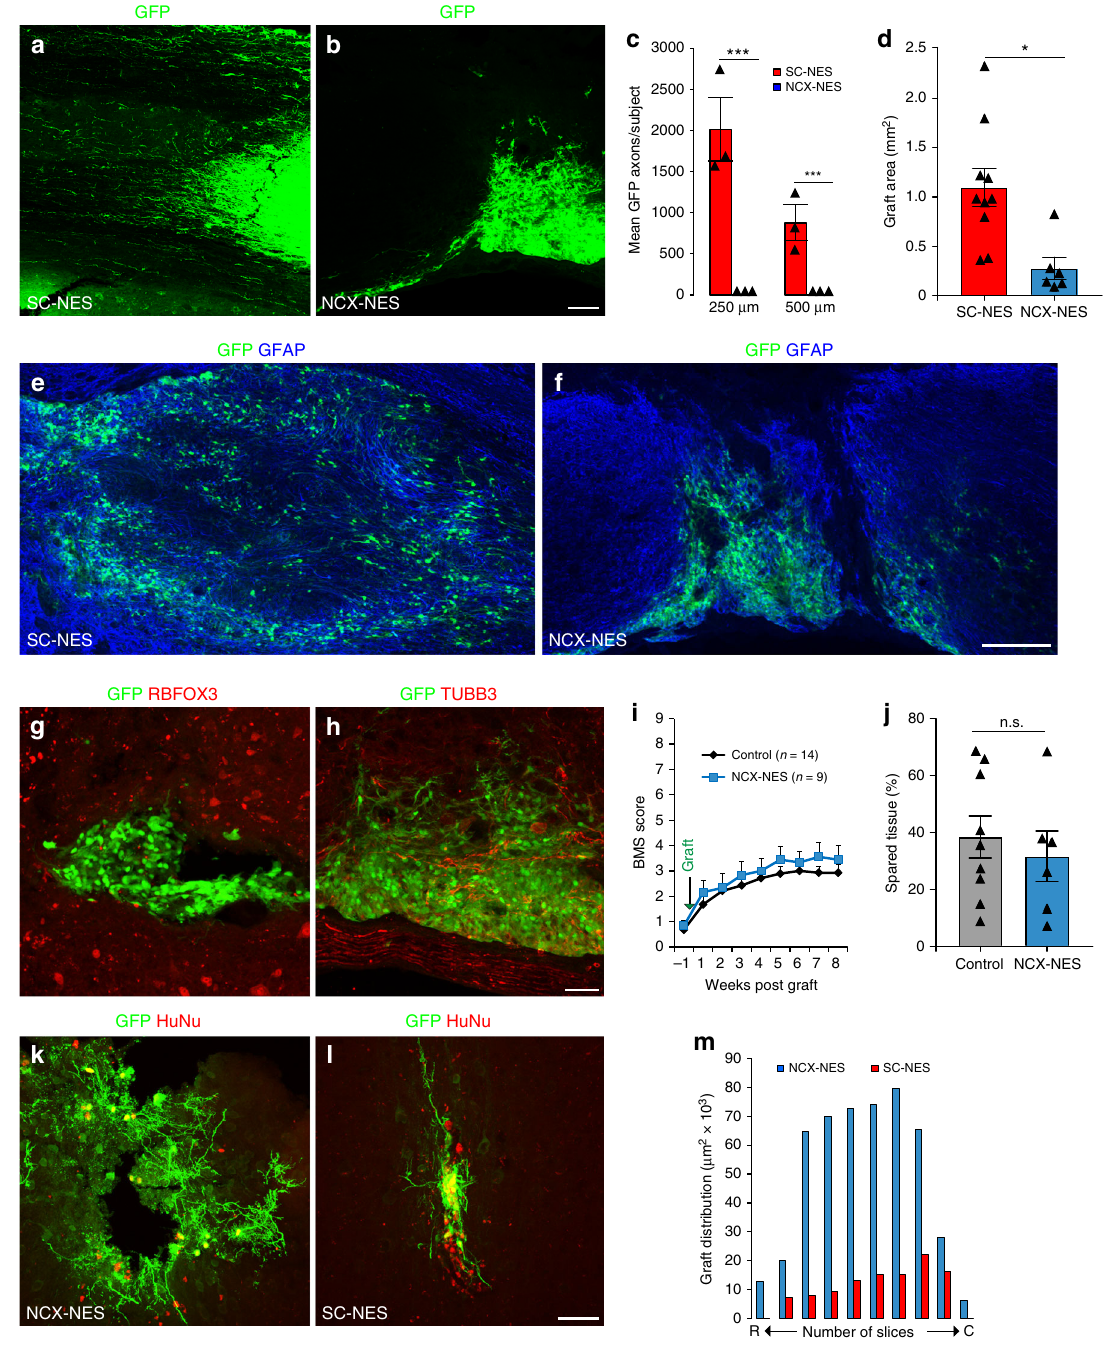
Fig. 6 Regionally matched NES cell grafts integrate in the lesioned SC. a GFP immunostaining of human SC-NES cells grafts in the lesioned SC 8 weeks after implantation. SC-NES cells integrate in the tissue and show a massive axonal elongation. b GFP immunostaining of human NCX-NES cell grafts. The cells form tight clusters in the host SC with a poor axonal extension. c Quanti fi cation of GFP-positive axons per subject in SC- and NCX-NES cell transplants. The plot indicates the number of axons at 250 and 500 µ m from the caudal graft-host interface. d Quanti fi cation of SC- and NCX-NES cell graft areas. e , f GFP and GFAP staining of SC- and NCX-NES cell grafts at the injection site showing a larger extension of SC-NES cell grafts in the host tissue. g , h Grafted NCX- NES cells are negative for the pan-neuronal markers RBFOX3 and TUBB3. i Hindlimb locomotion: BMS scores of NCX-NES cell recipient animals ( n = 9) and control animals ( n = 14) suggesting a lack of functional recovery in treated animals. j Spared tissue quanti fi cation in control and NCX-NES cell grafted mice. The histogram shows that the extent of the lesion in both groups is not statistically different. k , l GFP and human nuclei (HuNu) immunostaining of NCX-NES cells implanted in the motor cortex of immunode fi cient mice two months after surgery. m Rostro (R)-caudal (C) spread and graft extension in the coronal plane two months after engraftment of SC- and NCX-NES cells into the motor cortex of adult immunode fi cient mice. Data are expressed as mean ± s.e.m (* P < 0.05; *** P < 0.001; Student ’ s t -test). Scale bars: a , b , 500 µ m; e , f , 200 µ m, g , h , k , l , 50 µ